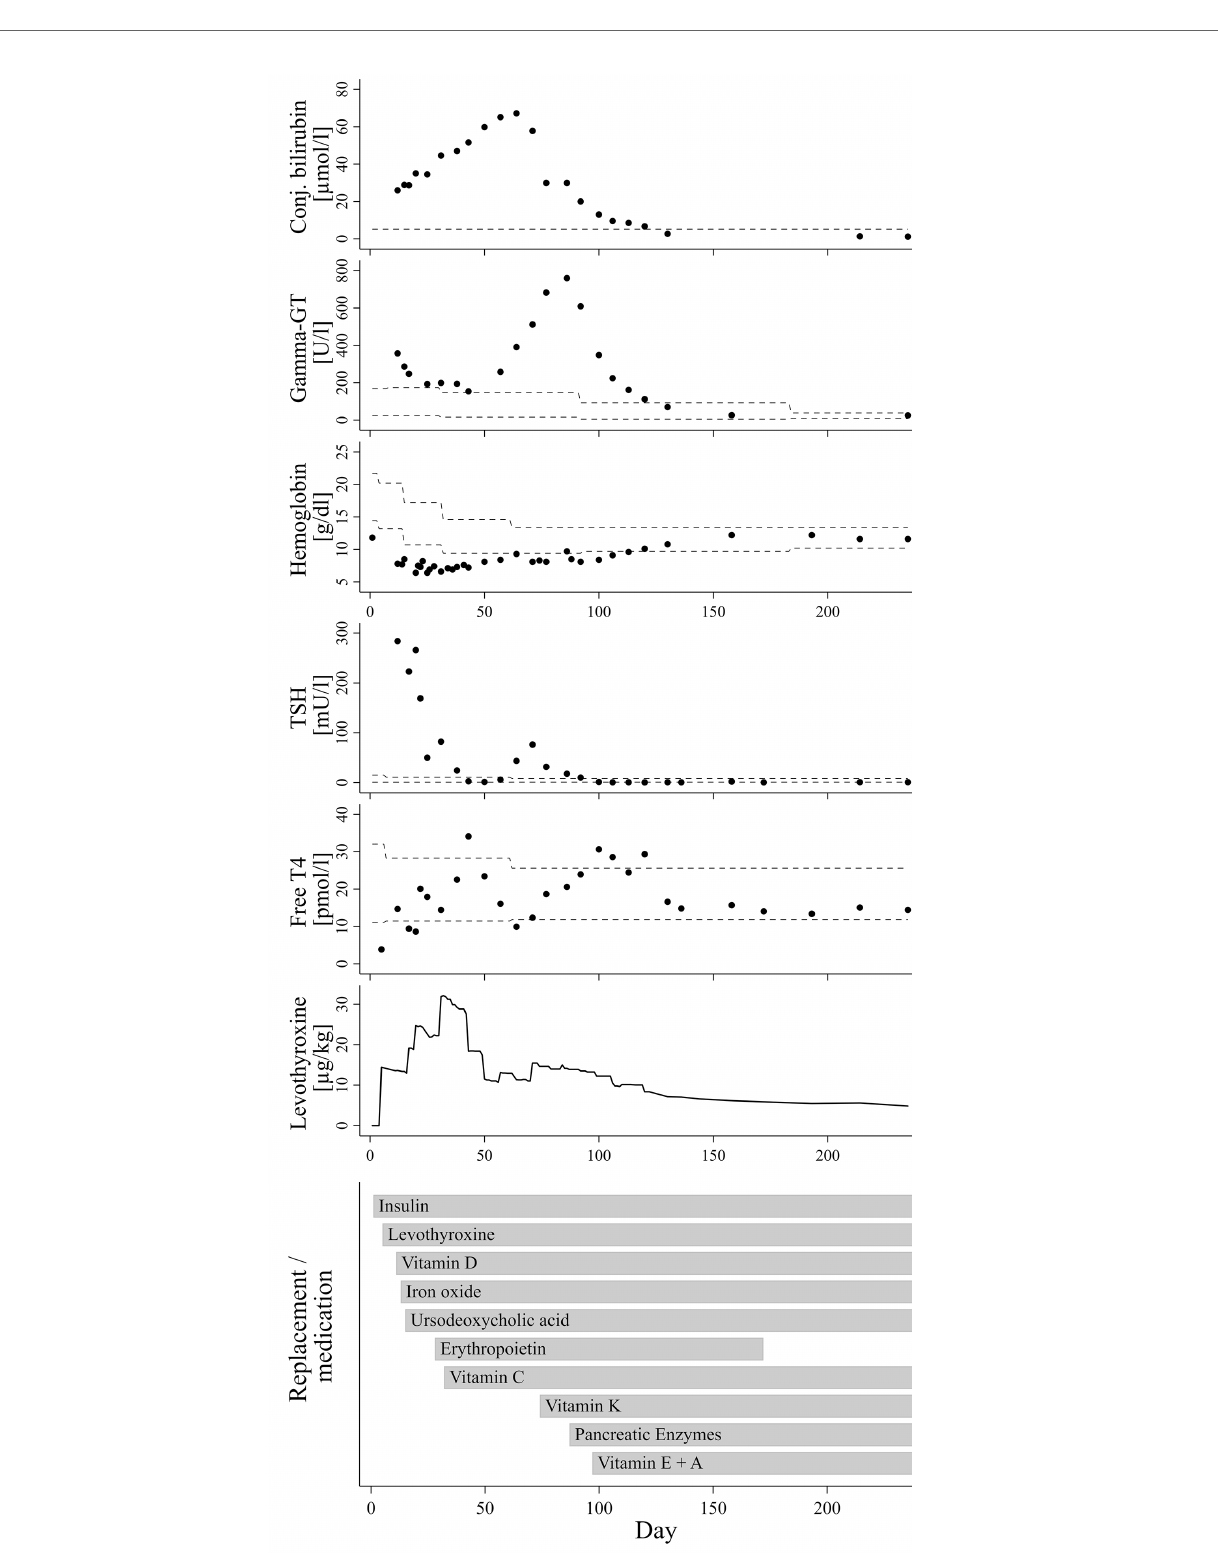
Splittstoesser et al.